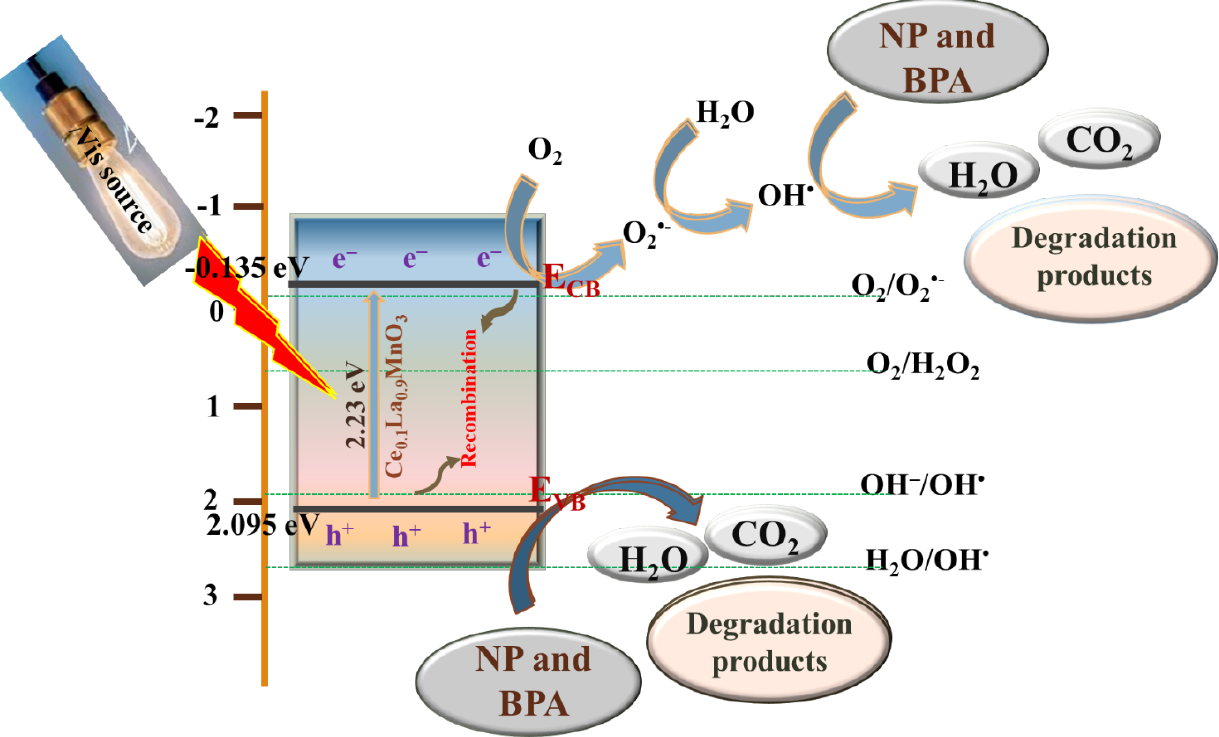
Figure 10. The energy band edge orientations of semiconductor and the plausible photochemical redox mechanism of NP and BPA pollutants over CLMO catalyst.